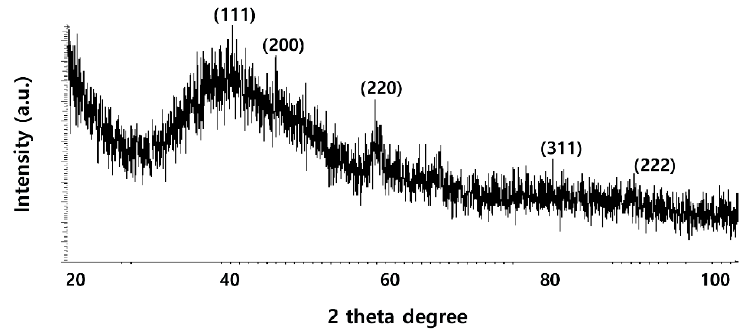
Figure 2. X-ray diffraction (XRD) pattern of dried palladium nanoparticles (PdNPs).